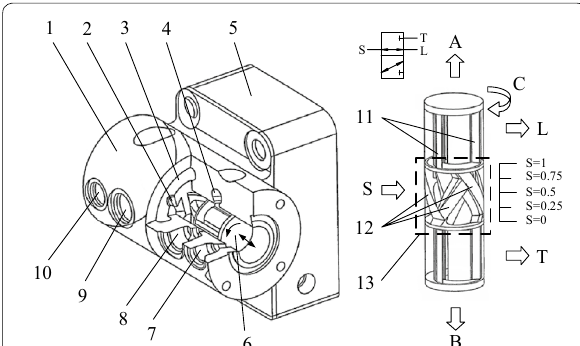
Figure 14 2-DOF high-speed on-off valve. 1. Valve sleeve; 2. Oil supply port; 3. Inlet annular passage; 4. Outlet annular passage; 5. Pump case (integrated with valve sleeve); 6. Rotary spool; 7. Right spool displacement control outlet; 8. Oil return port; 9. Load port; 10. Left spool displacement control outlet; 11. Outlet turbine blade; 12. Inlet turbine blade; 13. PWM control area; A: Oil return flow increasing direction; B: Load flow increasing direction; C: Spool rotary direction; S: Flow direction of supply oil; L: Flow direction of load flow; T: Flow